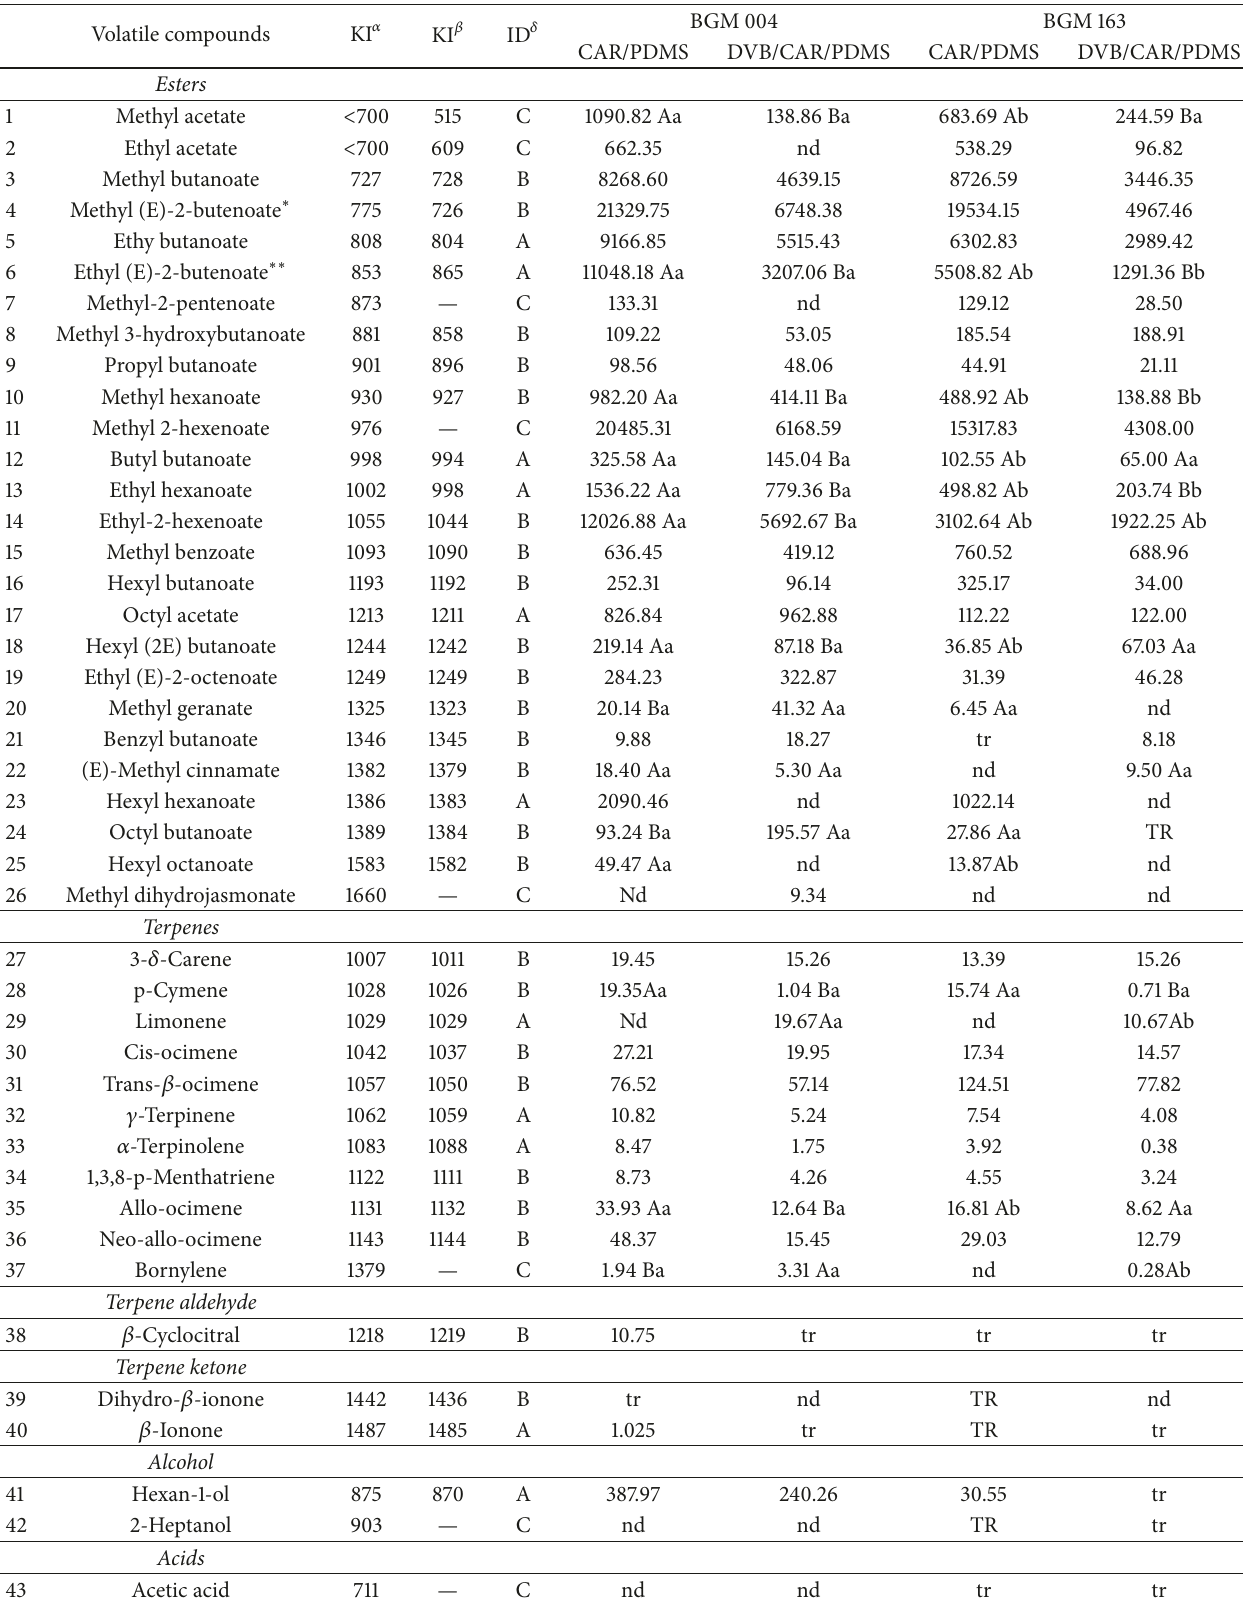
Table 1: Concentration of volatile compounds in the pulp of sweet passion fruit genotypes, extracted by two SPME fibers and properly identified and semiquantified ( 𝜇